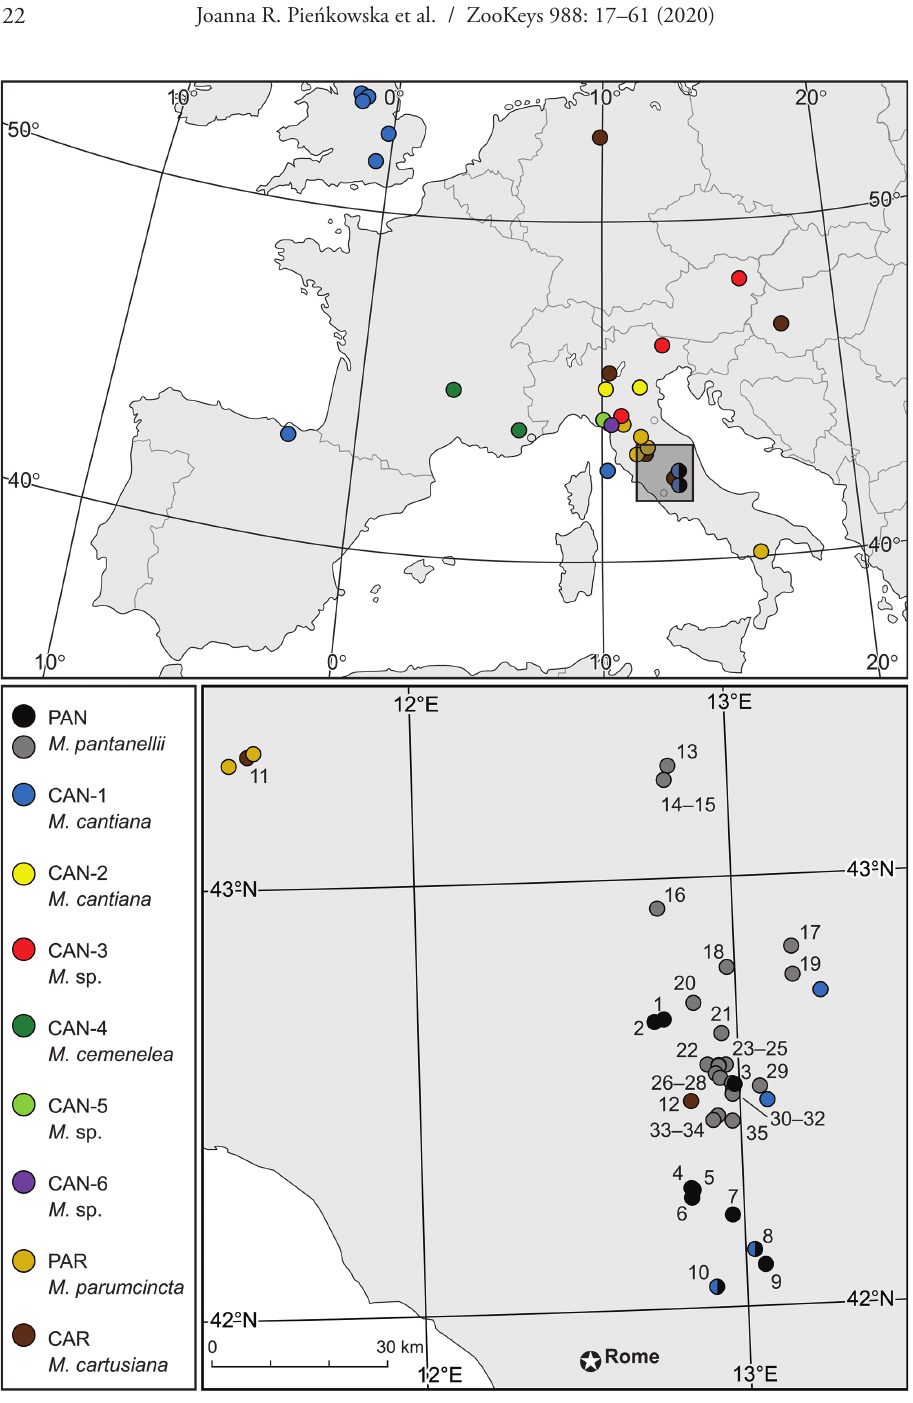
Figure 1. Localities of Monacha pantanellii and M. cartusiana populations listed in Tables 1, 3 ( M. pan- tanellii black circles Table 1, grey circles Table 3). Details of localities of other Monacha species and their molecular lineages were provided in previous papers (Pieńkowska et al. 2015, 2018a, 2018b,